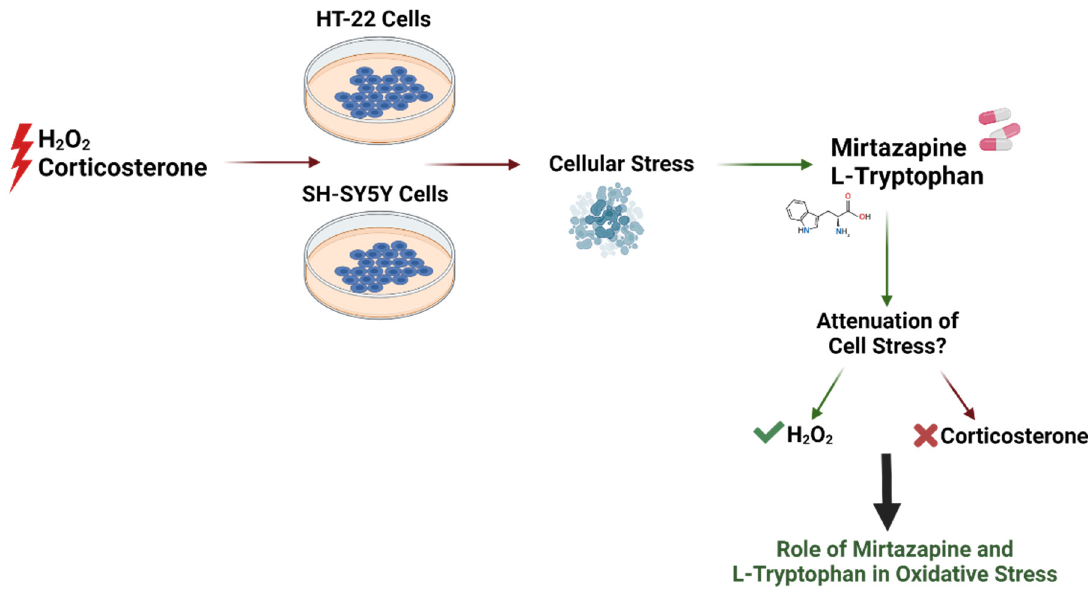
Figure 23. Schematic illustration of the main findings of this work. Created with Biorender.com